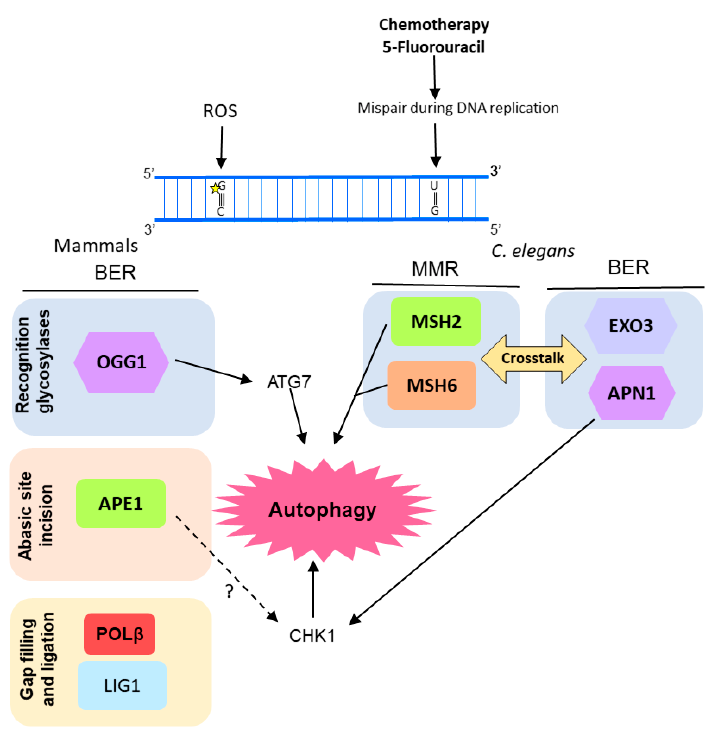
Figure 4. Diagram of the molecular mechanisms by which autophagy, BER, and MMR interacts in response to DNA lesions induced by reactive oxygen species (ROS) or chemotherapeutic agents. In human pulmonary cells, ROS-mediated DNA damage leads to an increase in OGG1 (8-oxoguanine glycosylase 1) expression and consequently autophagy (through interaction with ATG7, autophagy related 7). In Caenorhabditis elegans there is a crosstalk between BER and MMR, after induction of DNA damage by 5-fluorouracil (5-FU) that culminates in induction of autophagy and, eventually, cell death, probably mediated by the DNA damage response (DDR) protein CHK1. It is still an open question whether human APE1 also regulates CHK1 and it is represented by a question mark (?) in the figure.